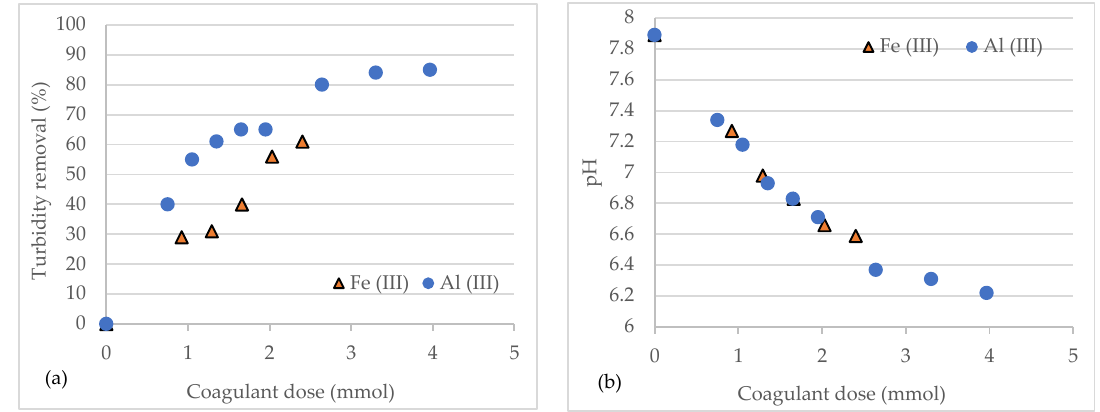
Figure 3. Turbidity removal ( a ) and pH change ( b ) during chemical coagulation of produced water.